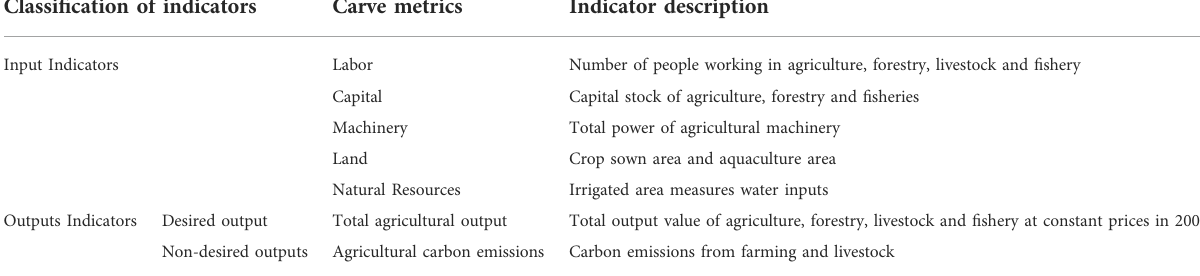
TABLE 1 Description of agricultural production input and output